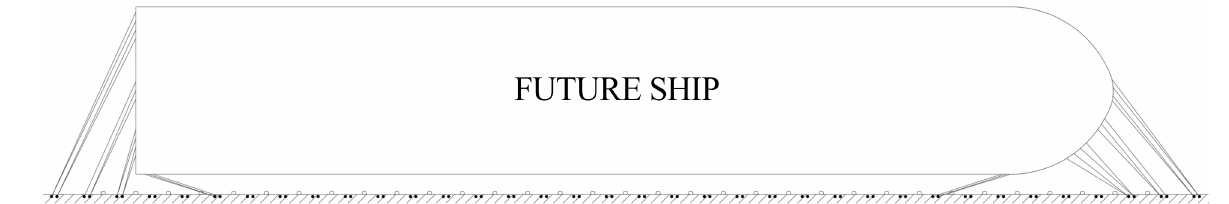
Figure 25. Example of the uncrossing mooring arrangement in the future